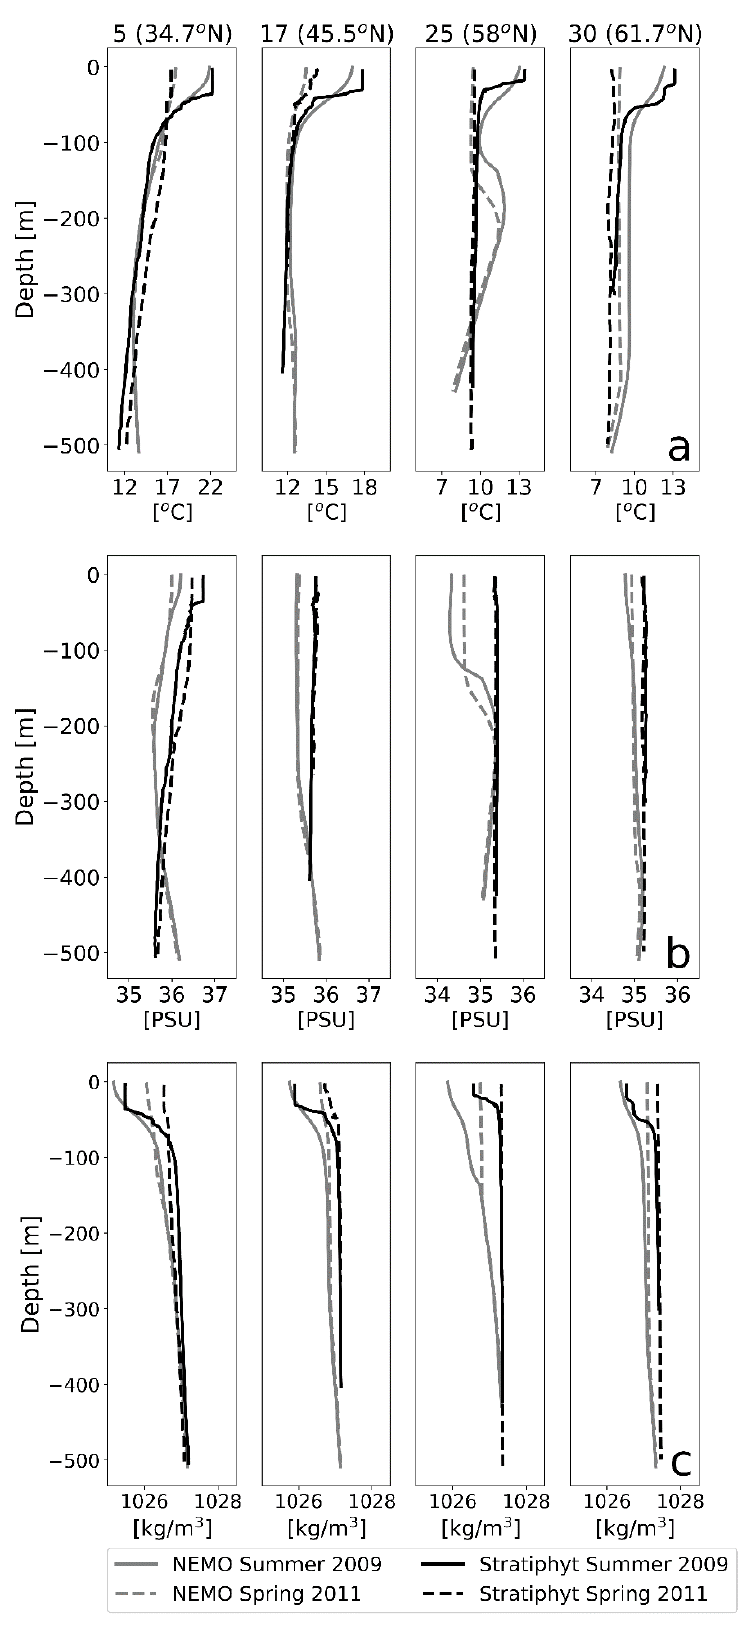
Figure 3. Temperature ( a ), salinity ( b ), and potential density ( c ) in the upper 500 m of Stratiphyt and NEMO (nucleus for European modelling of the ocean) run 1 at stations 5, 17, 25, and 30. Model results are April–May (2011) and June–August (2009) averages.